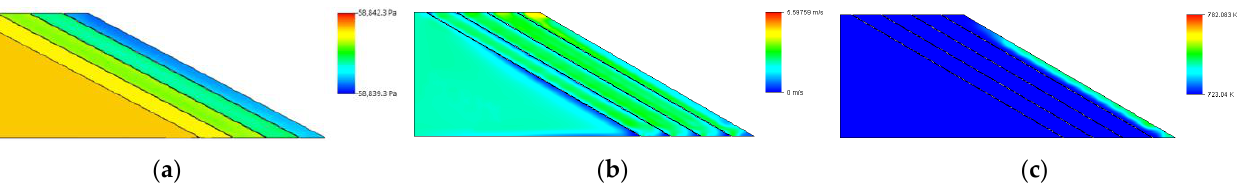
Figure 4. The data on the ( a ) pressure, ( b ) velocity, and ( c ) temperature profiles for the separator with arc-shaped elements.